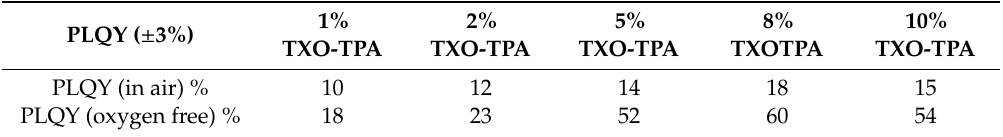
Photoluminescence quantum yield (PLQY) of films (host PVK:OXD-7) in air and oxygen-free